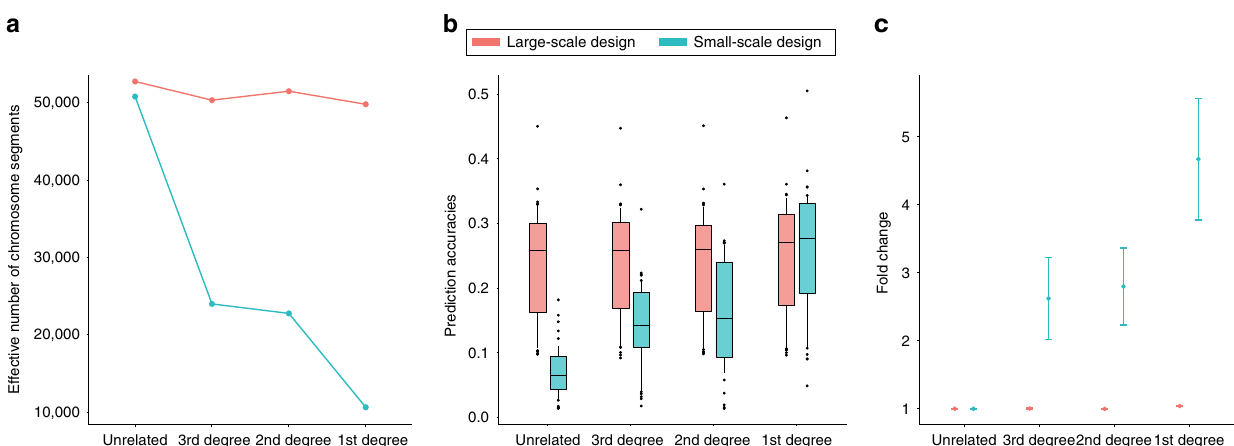
Fig. 2 A decreased effective number of chromosome segments can improve the polygenic prediction accuracy. The effective number of chromosome segments ( M e ) ( a ), the actual prediction accuracy ( b ) and the fold change of the prediction accuracy from each degree relatives with respect to that from unrelated samples in the large- and small-scale design ( c ). Accuracy of polygenic scores was calculated as the correlation between the polygenic score and the phenotype adjusted for batch, assessment center, sex, age and ten principal components of ancestry. M e is computed by the inverse of variance of genomic relationships between discovery and target sample. The dot points and error bars in ( b ) and ( c ) represent the mean values and 95% con fi dence intervals from the analyses of 50 complex traits. The boxplots ( b ) show the fi rst to the third quartile of prediction accuracies for 50 complex traits and the whiskers re fl ect the maximum and minimum values within 1.5 × interquantile range for each